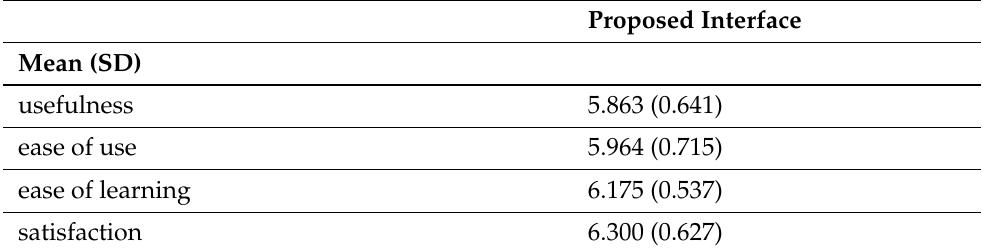
Table 1. Analysis results of satisfaction with the proposed text